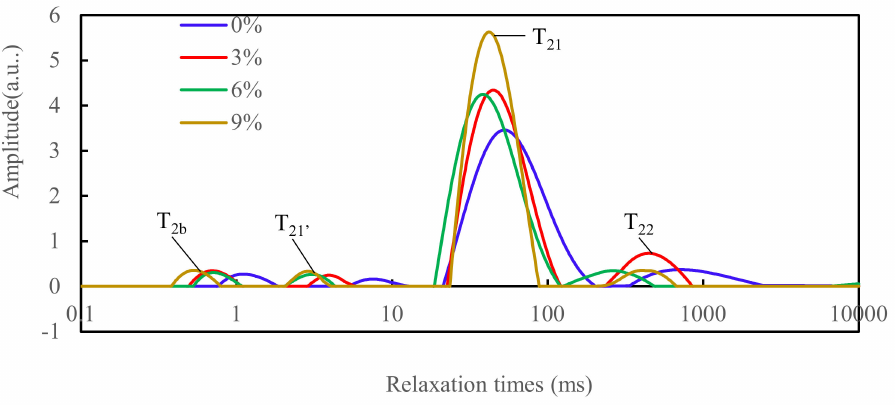
Figure 4. Effect of the pea protein addition levels (0%, 3%, 6% and 9%) on the distribution of the spin–spin relaxation times (T 2 ) of duck meat